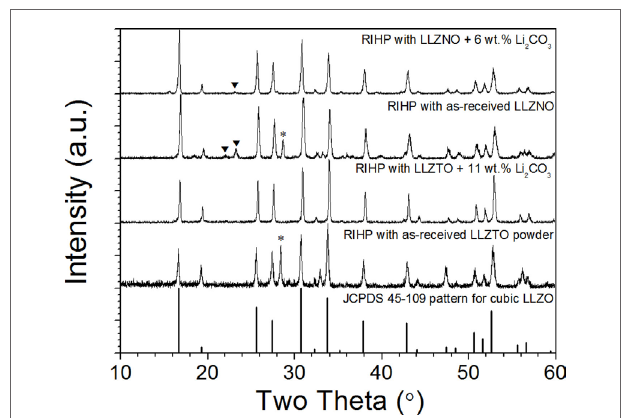
FigUre 2 | X-ray diffraction patterns of hot-pressed li 6.5 la 3 Zr 1.5 Ta 0.5 O 12 with 0 and 11 wt.% excess li 2 cO 3 , and li 6.5 la 3 Zr 1.5 nb 0.5 O 12 with 0 and 6